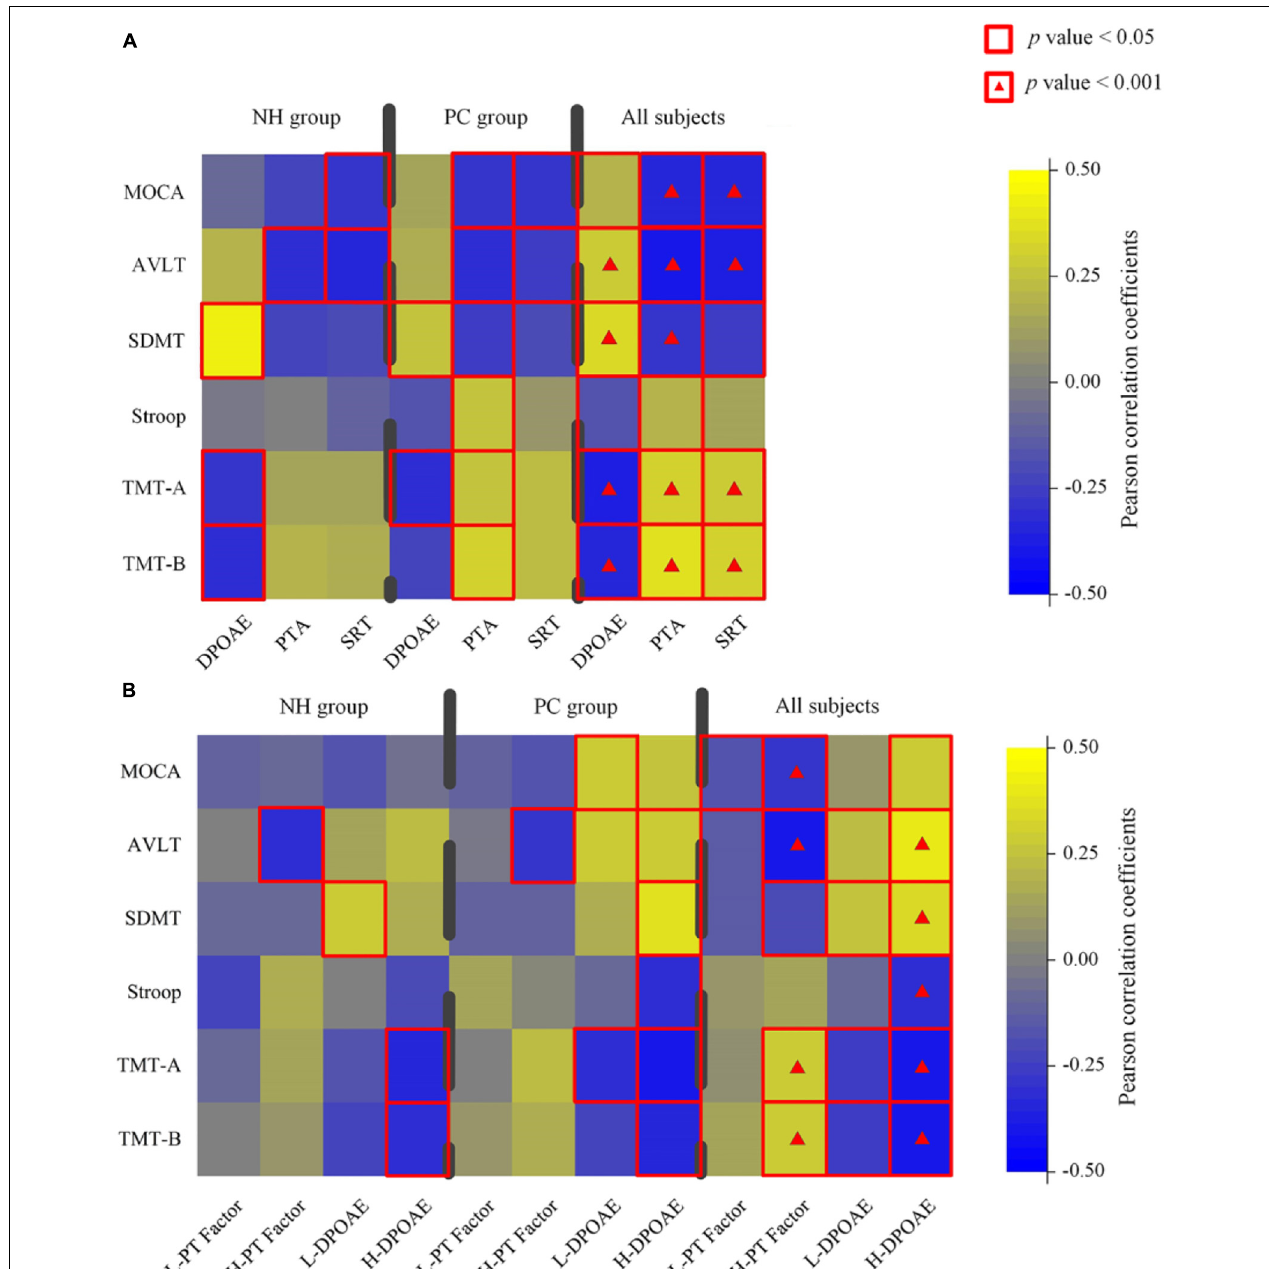
FIGURE 2 | Characterization of the relationship between hearing loss and cognitive data in normal hearing (NH), presbycusis (PC) groups, and all participants. (A) A correlation between all-frequency hearing assessments and cognitive scores in different groups. (B) A correlation between low/high-frequency hearing assessments and cognitive scores in different groups. Color scale represents Pearson correlation coefficient. Red square alone or with a hash indicates statistical significance, respectively, at a threshold of p < 0.05 and p < 0.001. PTA, pure tone average in four frequencies; PT, pure tone average in all frequencies; SRT, speech reception threshold; L/H, low/high frequency; MoCA, Montreal Cognitive Assessment; AVLT, Auditory Verbal Learning Test; SDMT, Symbol Digit Modalities Test; TMT, Trail-Making